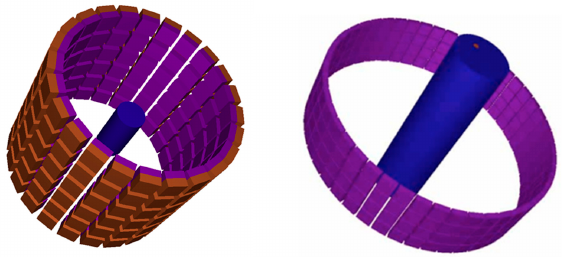
Figure 4. Schematic representation of the SuperArgus ( left ) and the Biograph TPTV scanners ( right ) simulated in PeneloPET.